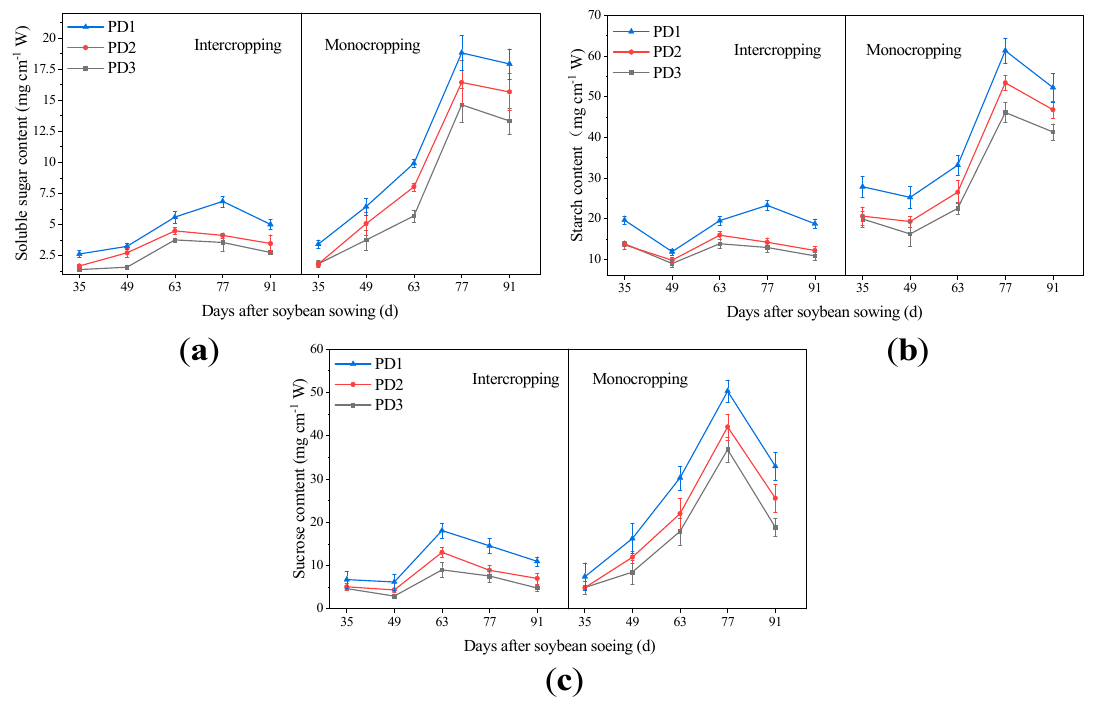
Figure 5. E ff ects of multiple planting densities (PD1 = 17, PD2 = 20, and PD3 = 25 plants m − 2 ) on soluble sugars ( a ), starch ( b ), and sucrose ( c ) under both strip intercropping system and monocropping. All values are means ( ± SE) standard error of three replications.